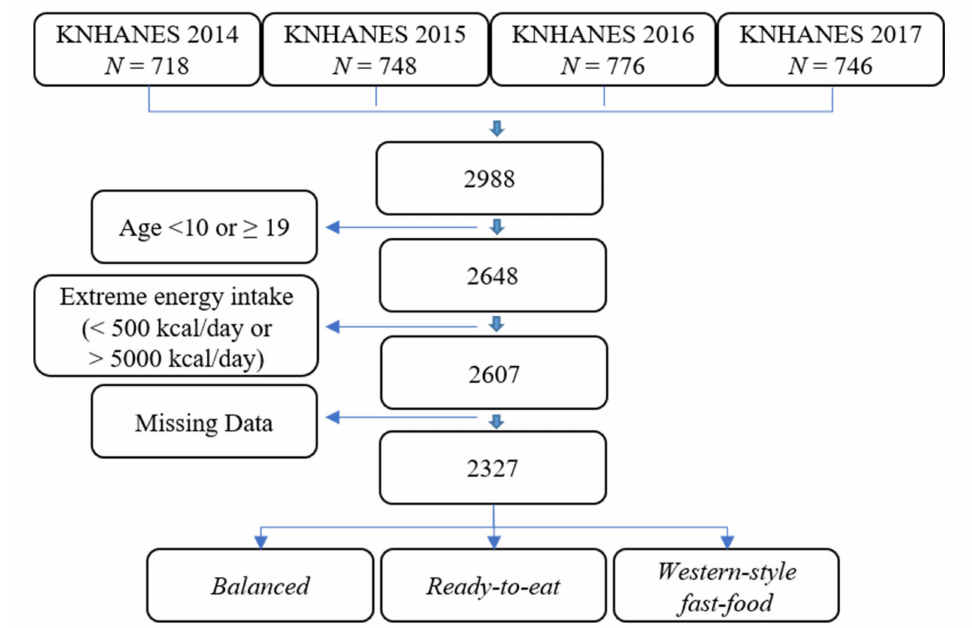
Figure 1. Flow chart for participant selection (2327 participants). KNHANES: Korean National Health and Nutrition Examination